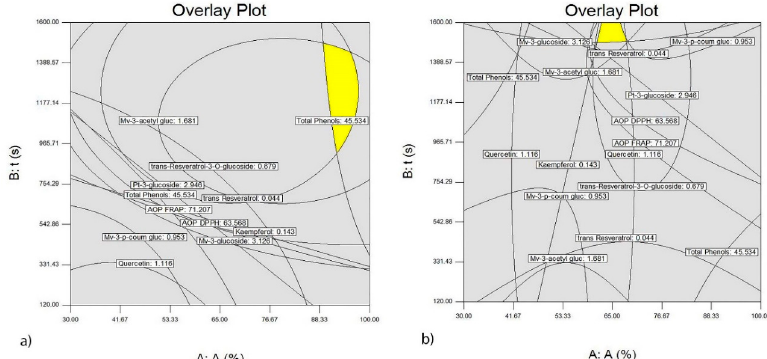
Figure 6. Optimal conditions of the ultrasound-assisted extraction of polyphenolic compounds from the wine lees of the Merlot variety which most significantly affect the AOP of the extracts using the ultrasonic probe with a diameter of 22 mm ( a ) and using the ultrasonic probe with a diameter of 40 mm ( b